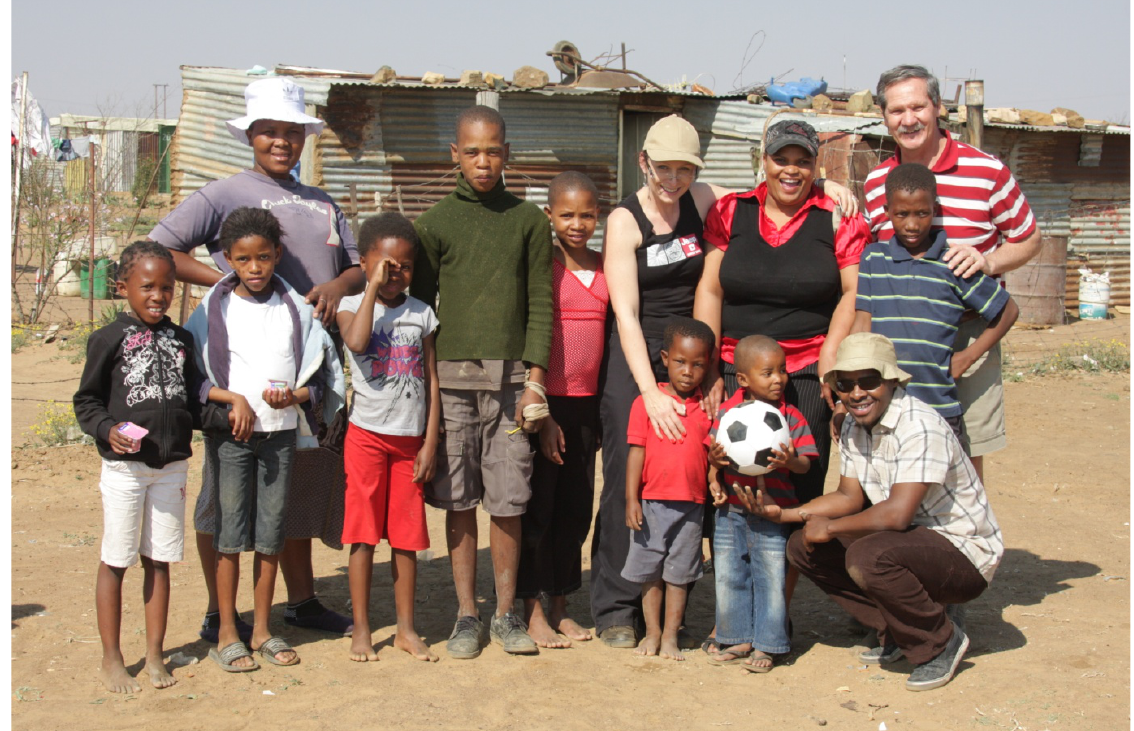
Figure 3 Researchers and members of the community in Sannieshof August